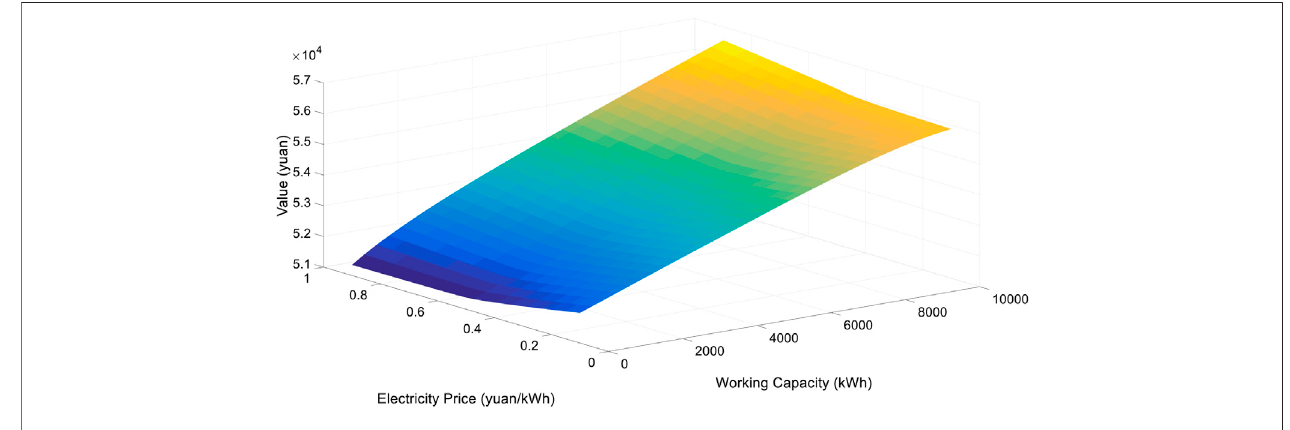
FIGURE 3 | Wind-power HESS value surface.